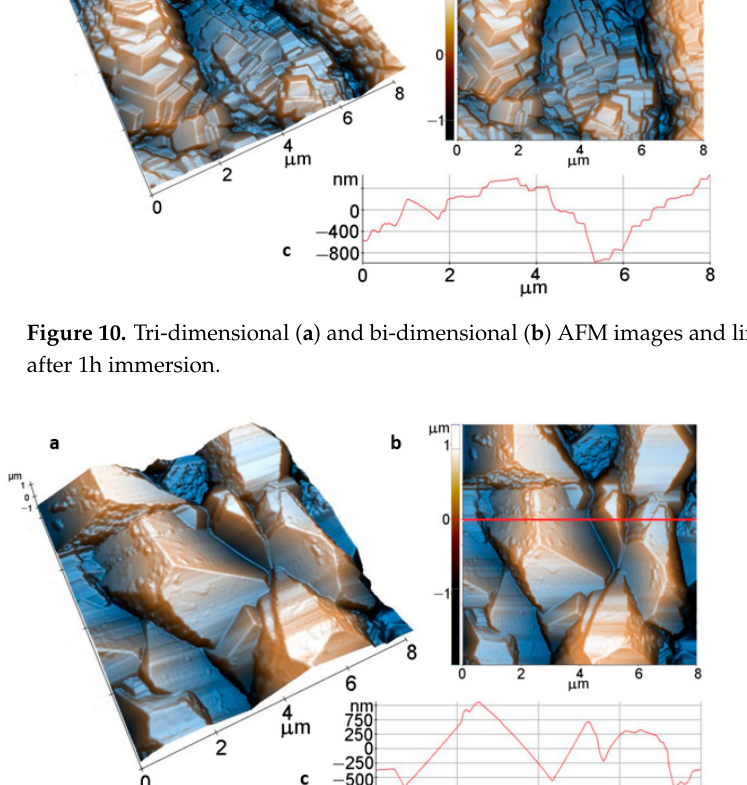
Figure 11. Tri-dimensional ( a ), bi-dimensional ( b ) AFM images taken on areas of: 8 µm × 8 µm; and AFM line profile ( c ) of Mg after 1 -day immersion.